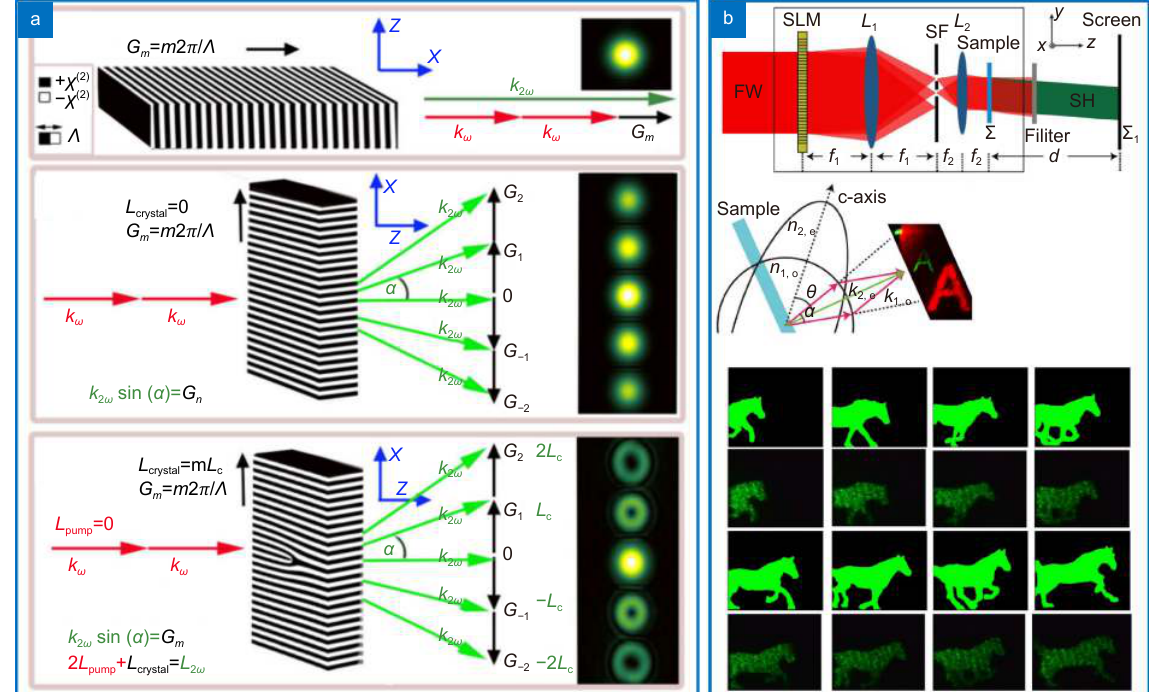
Fig. 3 | Nonlinear Holography. In ( a ) the structuring of the medium is illustrated: the fundamental field is always the same, but the medium is not. The selective inversion of the electric domain across the transverse plane creates different spatial structures in the second harmonic field. The periodical transverse structure is responsible for multiple phase matching mechanisms, both longitudinally and transversely. In ( b ) it is shown how non-collinear SHG can transfer a specific intensity pattern from one wavelength to the other. First row shows the imaging arrangement and the second column shows the phase-matching conditions and an example of output modes. Right below is a experimental demonstration that this can be used for real-time frequency conversion of computer generated holograms. Figure repoduced from: (a) ref. 130 , © American Physical Soci- ety; (b) ref. 158 , © Optica Publishing